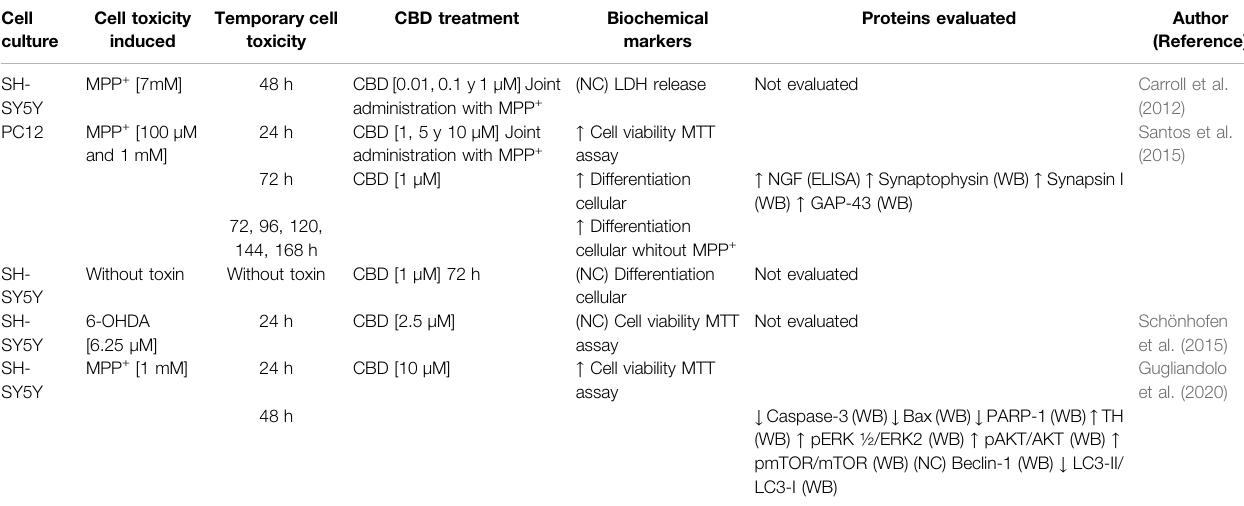
TABLE 3 | Research reports of effect CBD on various in vitro models of